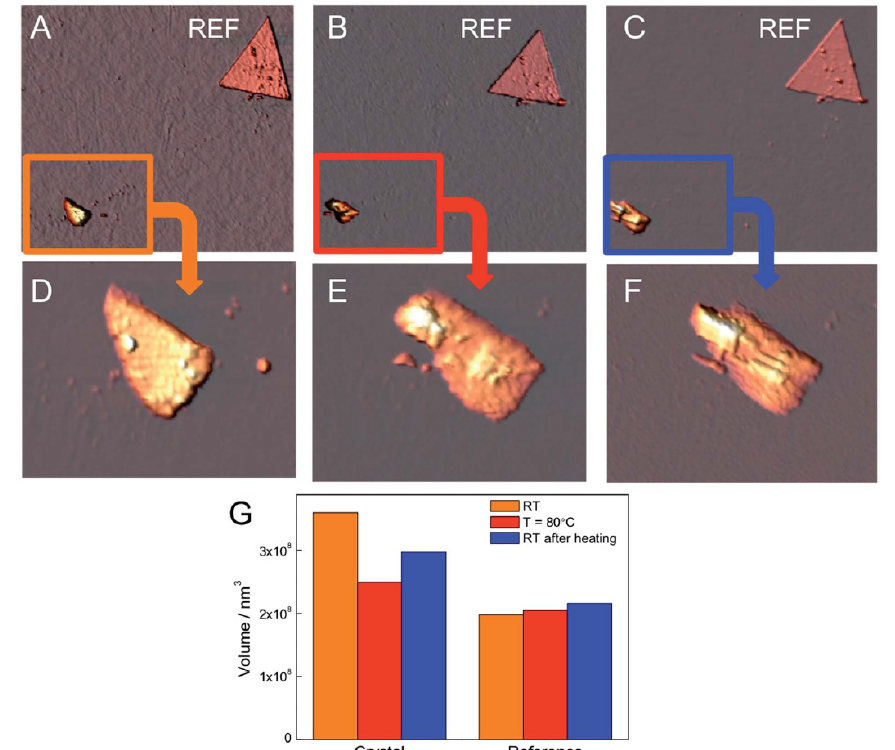
Figure 11. AFM images of the CoAl–LDH-AO5 acquired at room temperature (RT) ( A ); at 80 °C ( B ); and again at RT after the heating ( C ); In each image it is possible to distinguish a crystal and a reference marker. Image size 17 micron × 17 micron. ( D ), ( E ), and ( F ) correpond to magnifications of ( A ), ( B ), and ( C ) respectively to observe in